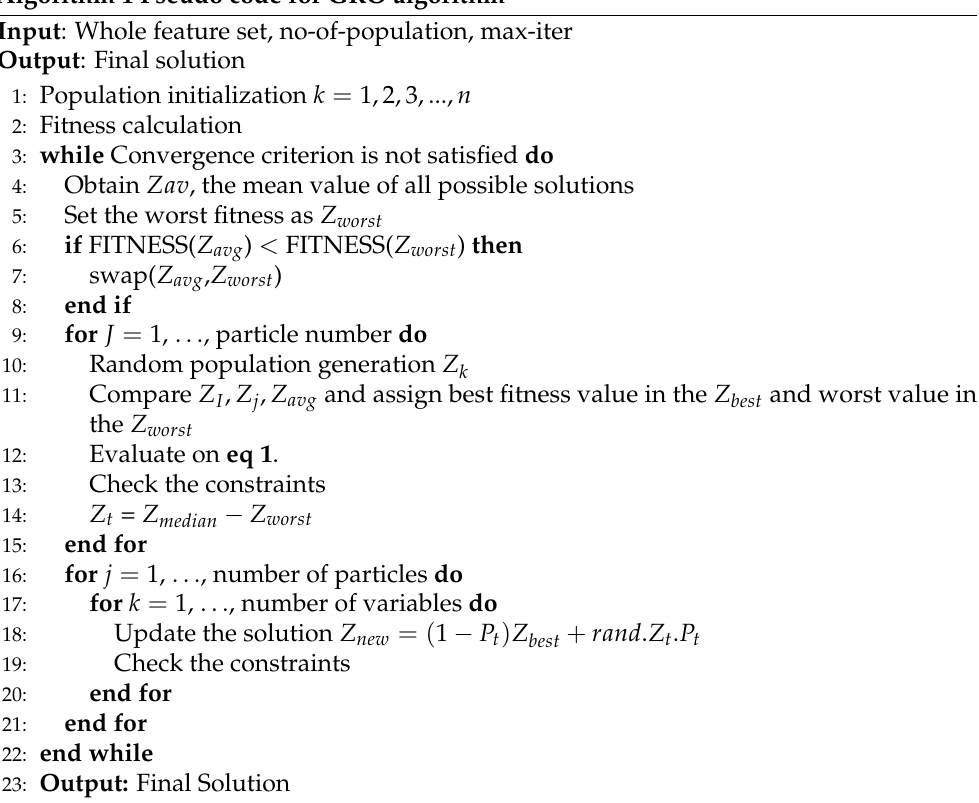
Algorithm 1 Pseudo code for GRO